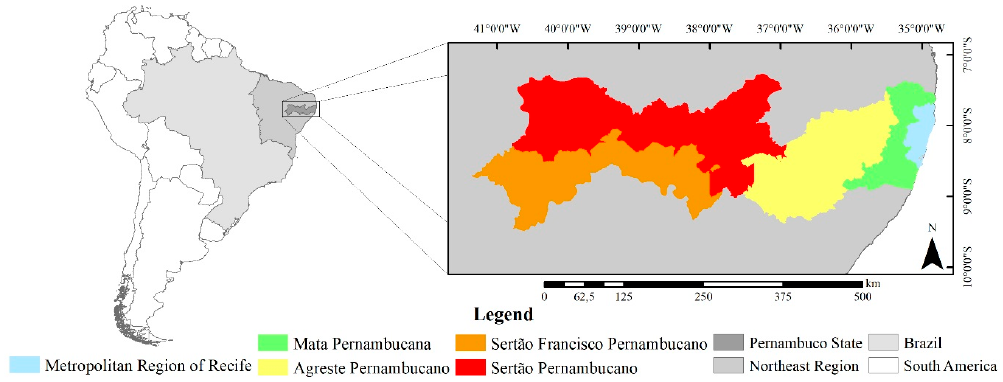
Figure 1. Location of Pernambuco State and its mesoregions.